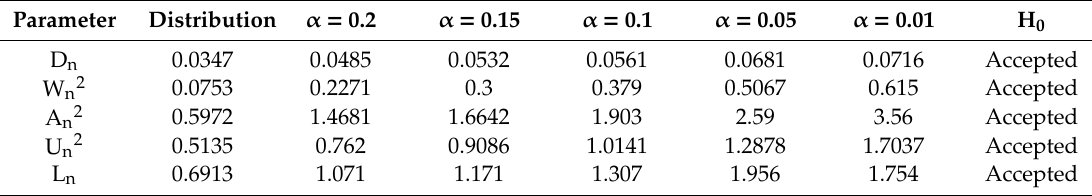
Table 3. The log-normal distribution goodness-of-fit test for monthly runo ff data in the Rasht